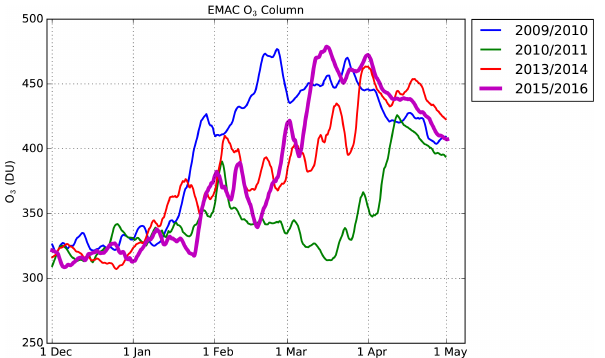
Figure 10. Ozone (O 3 ) column time series for the 2009/2010 (blue), 2010/2011 (green), 2013/2014 (red) and 2015/2016 (magenta) Arc- tic winters, averaged over 60–90 ◦ N (results from the EMAC T42L90 simulation are shown here).